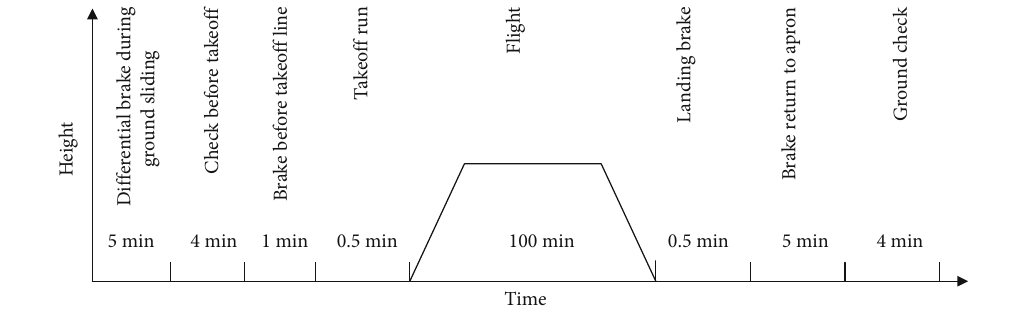
Figure 24: Mission pro fi le of the aircraft brake system. Table 3: The service life under erosion and